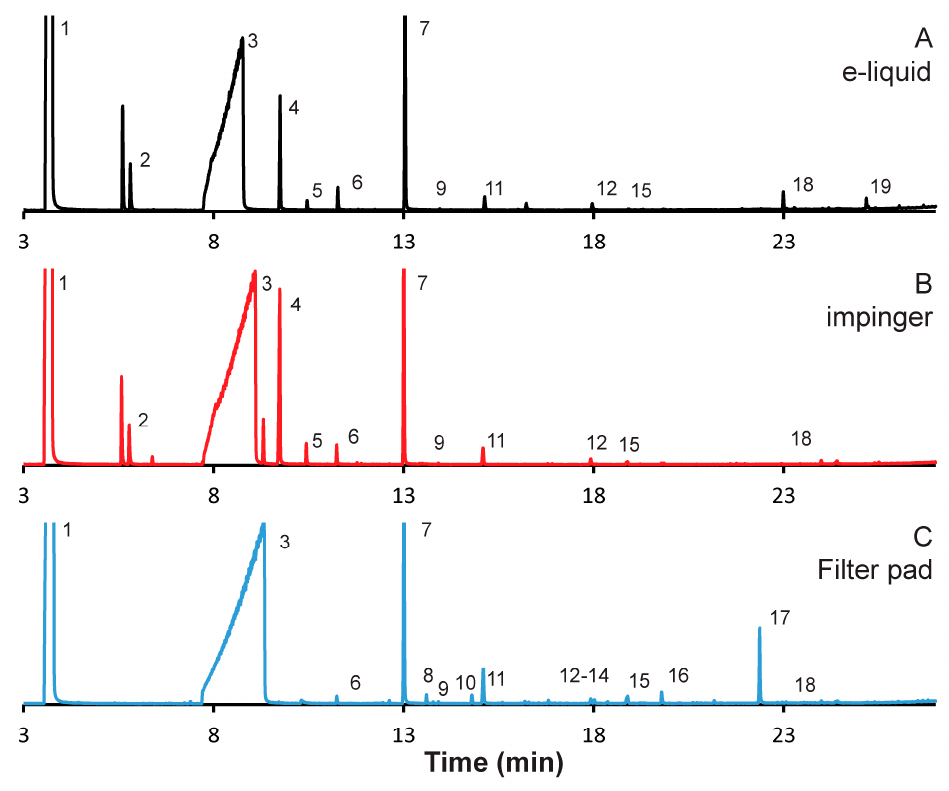
Figure 1. Gas chromatogram (GC) analysis of aerosol emissions resulting from vanilla flavored e-liquid using alternative captured methods. Emissions were collected from 100 puffs under realistic topography conditions. Chromatograms reflect ( A ) e-liquid diluted in methanol, and emissions collected: ( B ) with series impinger 1; and ( C ) on 10 Cambridge pads, with 10 puffs per pad. Table 2. GC-MS analysis of molecules in observed in aerosols generated from 100 puffs of vanilla flavor e-liquid, in emissions captured with pads, and methanol impingers.